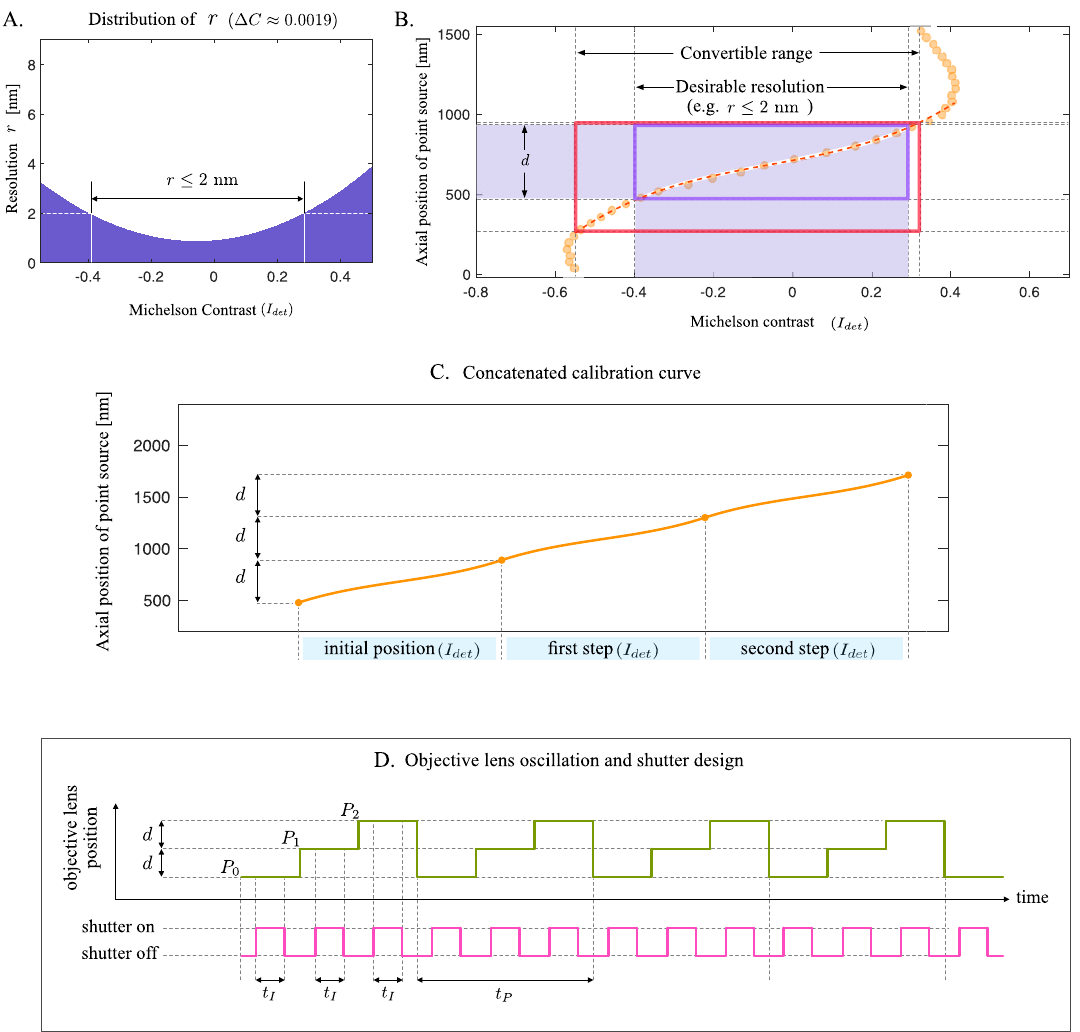
Figure 5. ( A ) Distribution of calibration resolution r upon I det in the convertible range, for 8-bit resolution images; ( B ) final trackable range determined by user-defined range of calibration resolution r ; ( C ) completed concatenated calibration curve for two-step objective lens oscillation; ( D ) practical imaging plan for extension of dual-focus optics trackable range. P 0 , P 1 , and P 2 indicate the position of objective lens for two-step oscillation; t I indicates the imaging time where the shutter in front of the camera sensor is open (the shutter exposure time); t P denotes the total time consumed by a single scan, which corresponds to the time interval between the same axial position of the objective